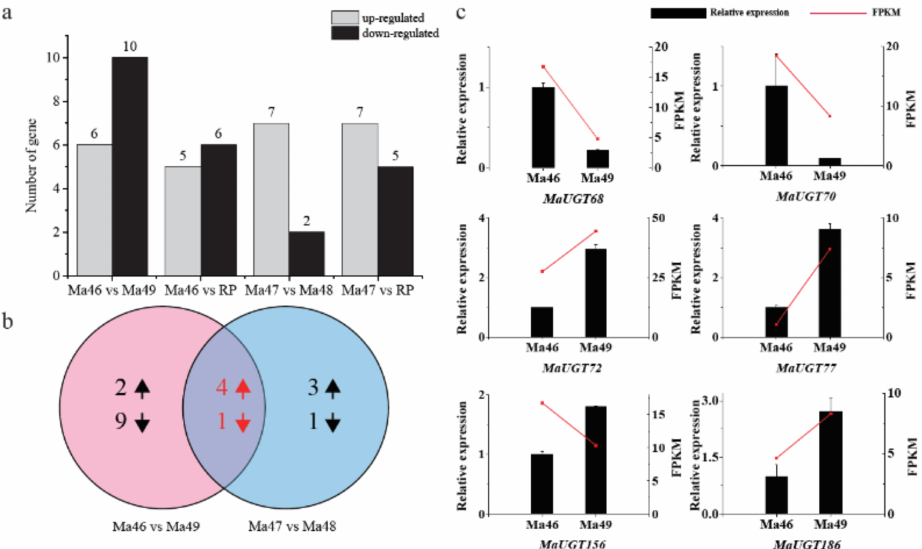
Figure 3. Differential gene expressions of coumarin biosynthesis-related MaUGTs . ( a ) The number of up and downregulated genes in the comparisons of Ma46 vs. Ma49; Ma46 vs. RP; Ma47 vs. Ma48; and Ma47 vs. RP. The number at the top of the column represents the differentially expressed MaUGT gene numbers. ( b ) Venn diagrams of the DEGs from Ma46 vs. Ma49 and Ma47 vs. Ma48. Up arrows represent upregulation, down arrows represent downregulation. The red arrows and numbers indicate the upregulated and downregulated gene numbers that overlapped between Ma46 vs. Ma49 and Ma47 vs. Ma48. ( c ) Confirmation of the expression patterns of the MaUGT genes involved in coumarin biosynthesis using qRT–PCR. The values shown are the means ± standard deviation of three replicates. Matubulin was used as the reference gene. Red lines indicate the expression values (FPKM) from RNA-seq data. CK represents